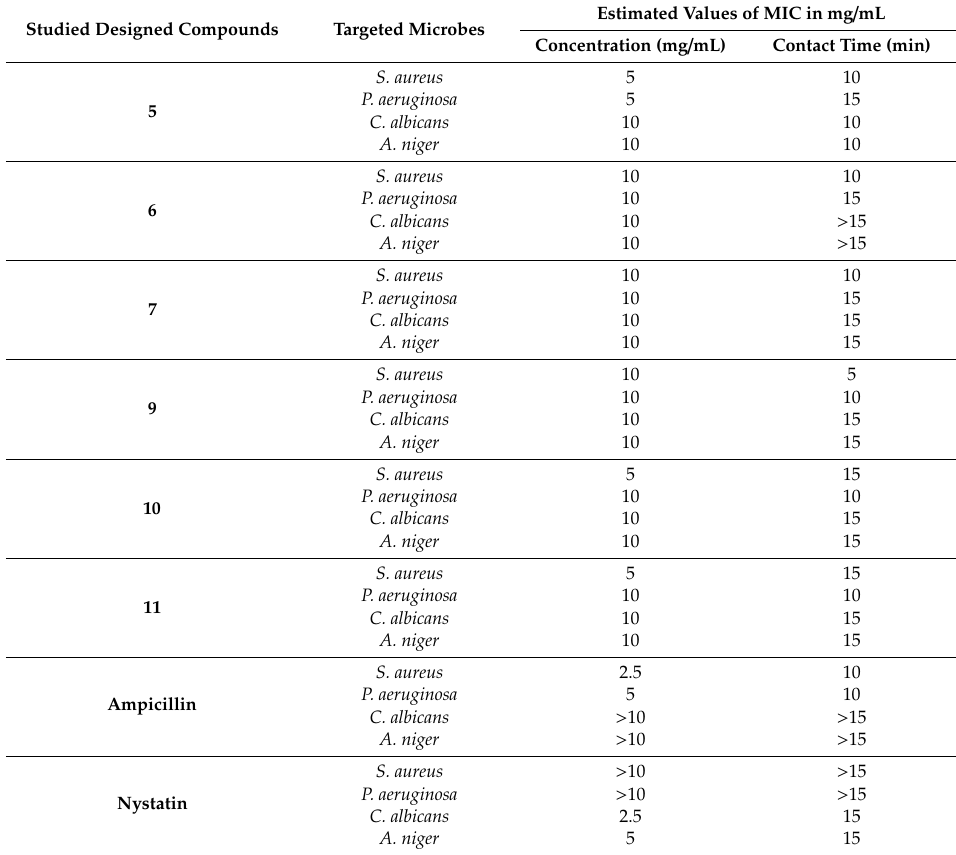
Table 2. Summaries of the estimated values of minimum inhibitory concentration (MIC) for the tested compounds towards targeted